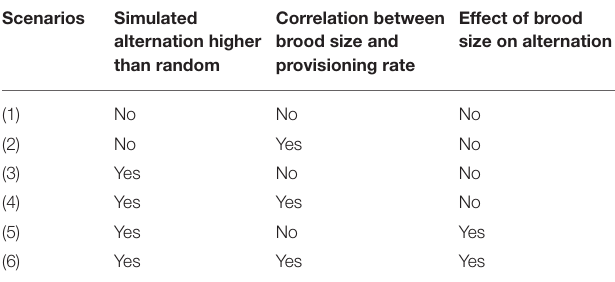
TABLE 1 | Summary of the effects simulated in each of the six scenarios that were built to define which statistical models would be most appropriate for analyzing variation in